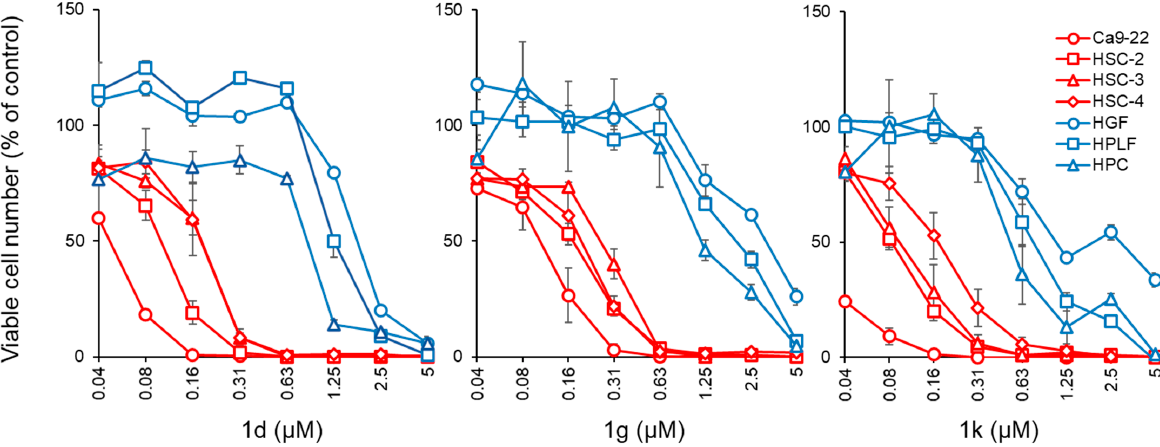
Figure 2. Kinetics of cytotoxicity induction by 1d , 1g, and 1k on human oral squamous cell lines (Ca9-22, HSC-2, HSC-3, and HSC-4) and human normal oral cells (HGF, HPLF, and HPC). These cells were incubated for 48 h with the indicated concentrations of 1d , 1g, and 1k , and the viable cell number was determined by MTT [3-(4,5-dimethylthiazol-2-yl)-2,5-diphenyltetrazolium bromide] methods. Each value represents the mean ± S.D. (standard deviation) of triplicate assays. Table 2. Evaluation of 1a – l and 2a , b against human HGF, HPLF, and HPC non-malignant cells.